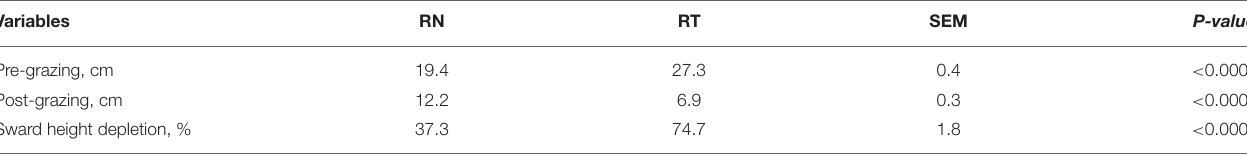
TABLE 1 | Sward surface height and sward height depletion of vegetative Italian ryegrass pastures grazed by sheep under contrasting grazing management strategies (RN and RT) in rotational stocking. Variables RN RT SEM P-value Pre-grazing, cm Post-grazing, cm Sward height depletion, %